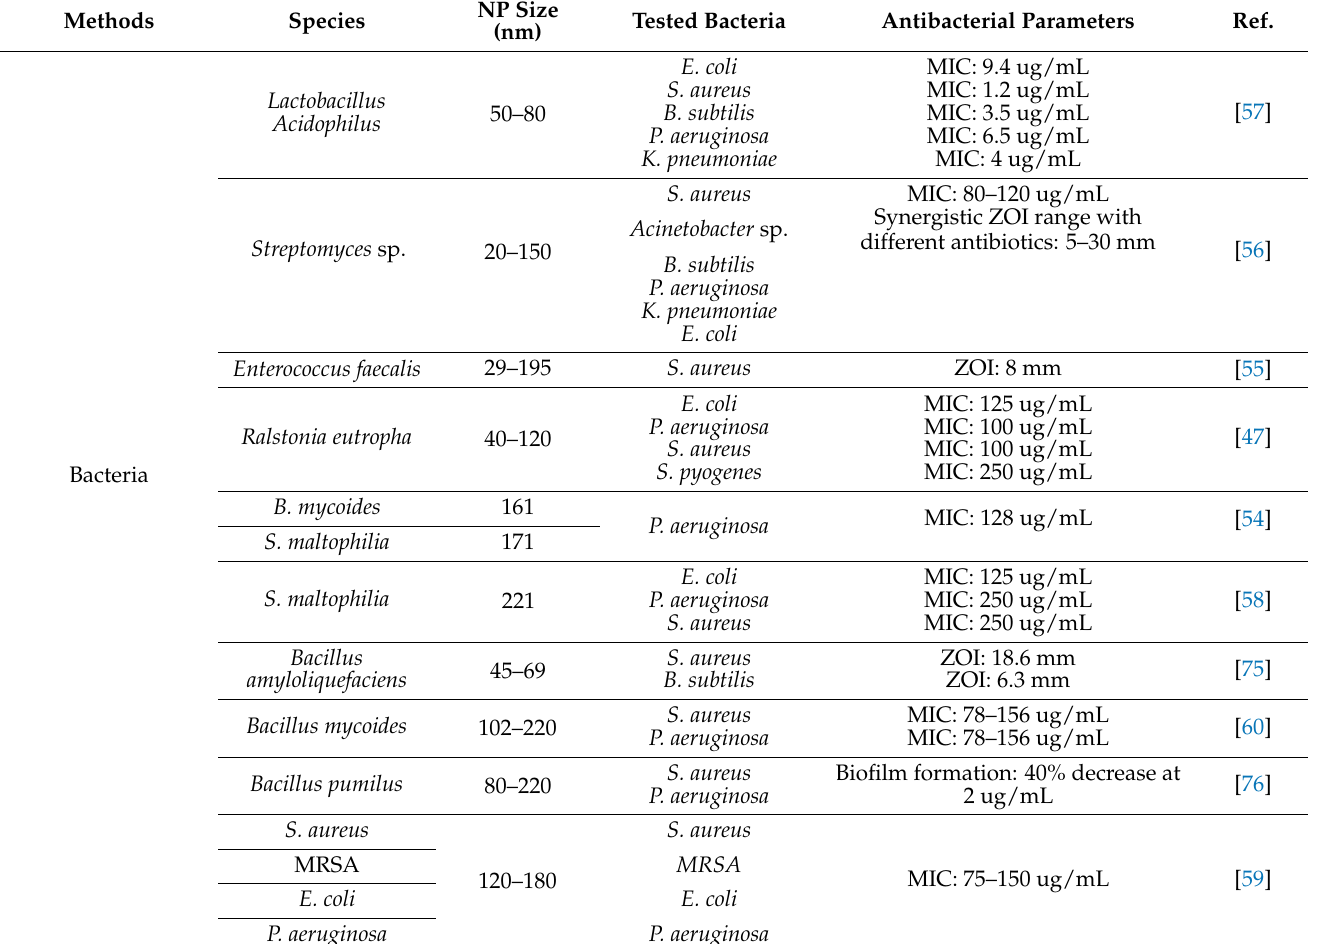
Table 2. Advances of green synthesis of SeNPs with antimicrobial applications. NP Size Methods Species Tested Bacteria Antibacterial Parameters (nm)